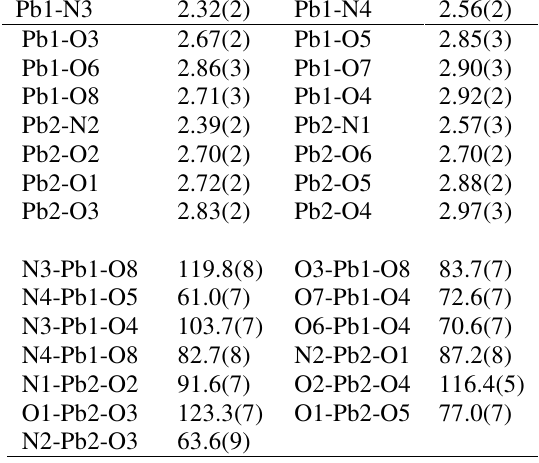
(dmp) (hfacac) ] 2 2 4